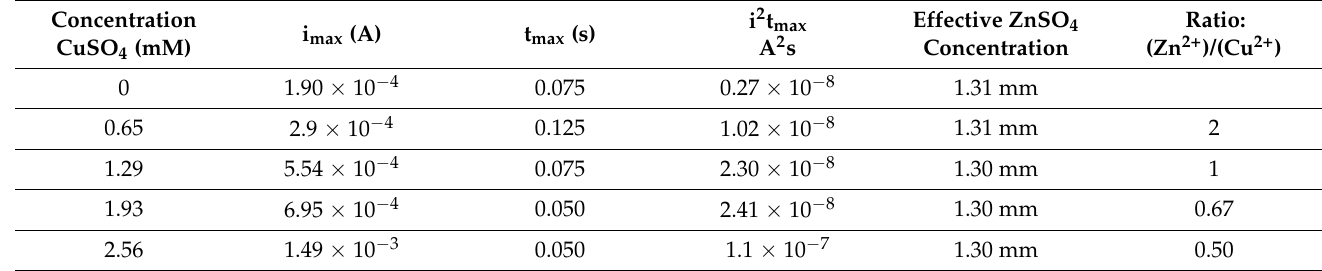
Table 3. Influence of the cupric ion in potential-step electrolysis.